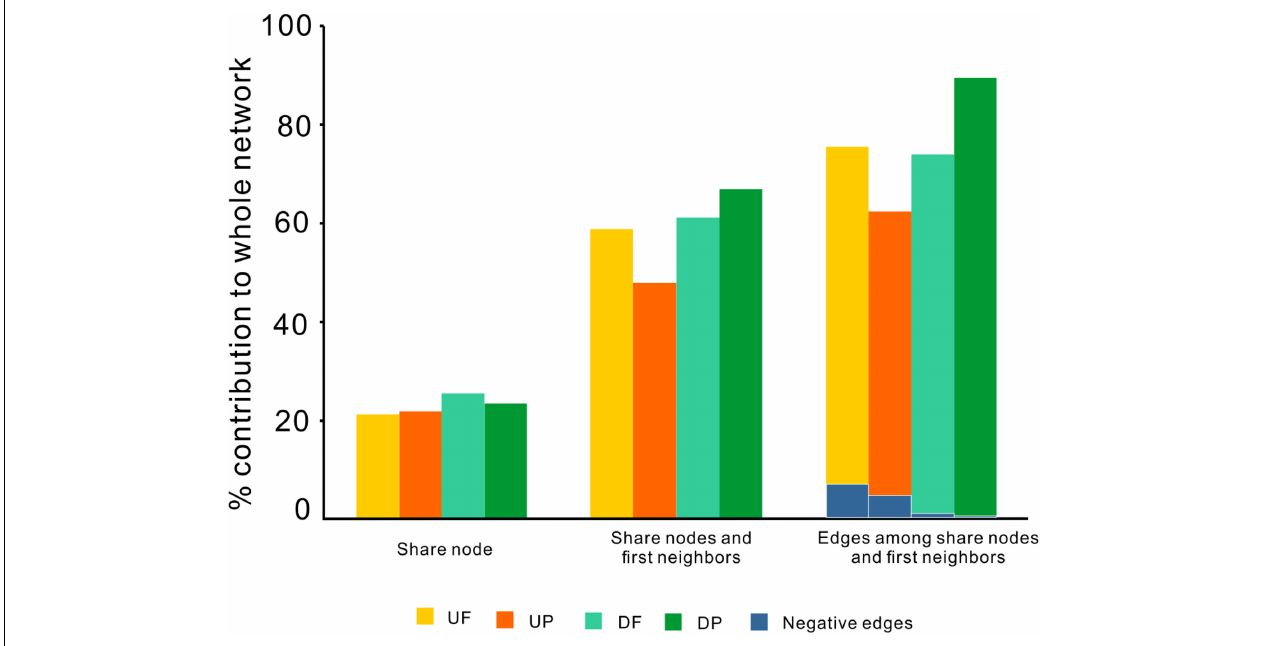
FIGURE 5 | The contributions of shared OTUs and their first neighbors to the whole networks. UF, free-living network for upstream; UP, particle-attached network for upstream; DF, free-living network for downstream; DP, particle-attached network for downstream.